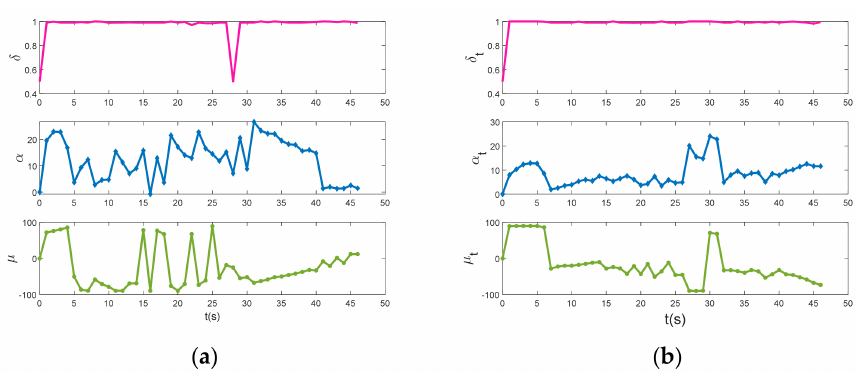
Figure 20. Decision process control variable curve. ( a ) UCAV; ( b )